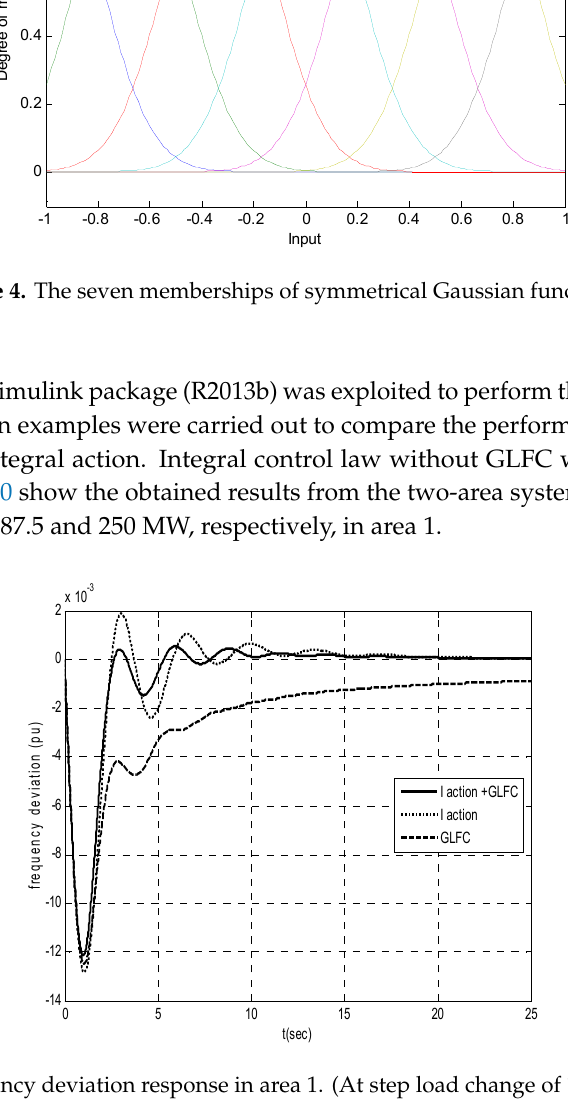
Figure 6. The frequency deviation response in area 2. (at step load change of 187.5 MW in area 1)